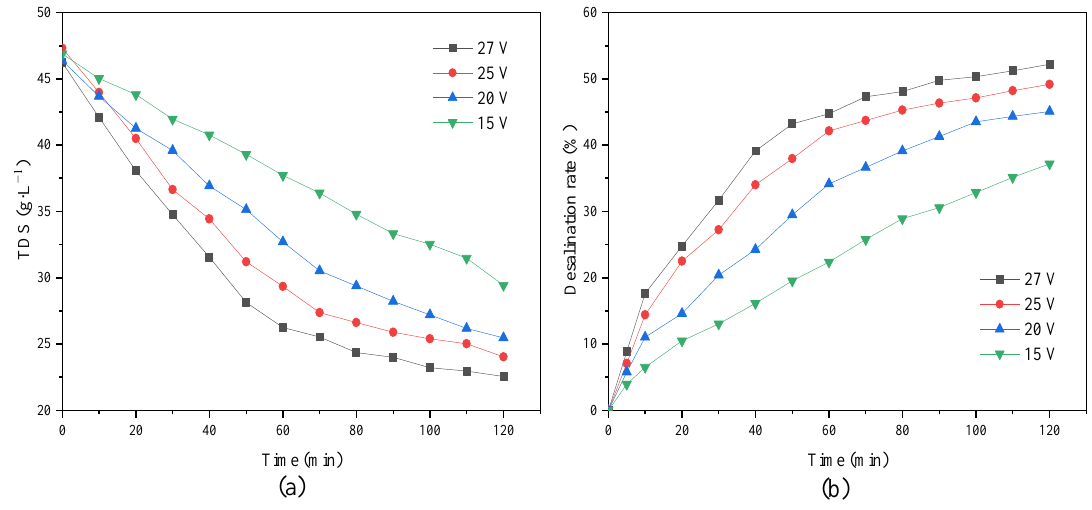
Figure 16. Variations in desalination rate ( a ) and TDS ( b ) under different voltages. This showed that with an increase in voltage, the current increased. Due to the constant membrane area and current density, the transmembrane migration of ions in the desalination chamber to the concentrated chamber increased. Thus, the recovery rate of inorganic salts improved. At this time, most salts in the concentrated water were recovered. As shown in Figure 17, the chloride in the concentrated water was essentially removed, and the rest was basically sulfate. The reason for the analysis is that the properties of different ions are different, indicating that under different voltages, the removal rate of Cl − is faster than that of SO 42 − , and Cl − can be removed more effectively at the same time.